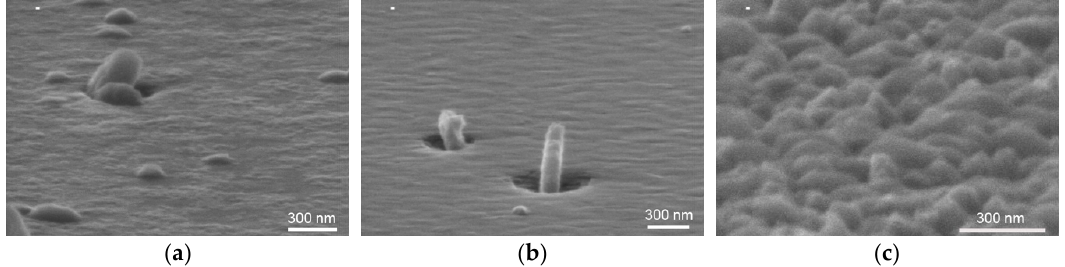
Figure 2. SEM images of the GaSe layers grown on the epi-ready GaAs(001) substrates at T S ~ 400 °C. The Se/Ga (BEP) flux ratios and growth rates were the following: ( a ) Se/Ga (BEP) ~ 42, r GaSe ≈ 1.13 nm/min, sample # GS2 ; ( b ) Se/Ga(BEP) ~ 34, r GaSe ≈ 1.3 nm/min, # GS1 ; ( c ) Se/Ga (BEP) ~ 12–13, r GaSe ≈ 5 nm/min, # GS5 . The thicknesses of the structures ranged within 200–300 nm. In the case of using standard Ga and Se valve cracking cell with T Se (cr) = 500 ◦ C as molecular beam sources, the stoichiometric Se / Ga ratio at T S = 400 ◦ C corresponds to the P Se / P Ga (BEP) ~